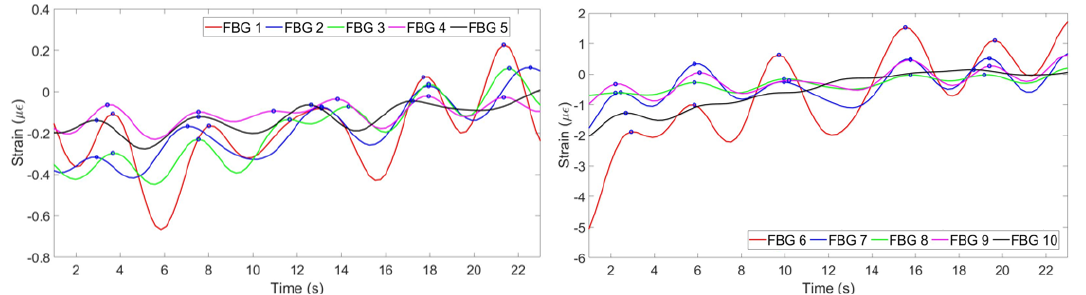
Figure 22. Breathing pattern for the first volunteer in the running position detected by: FBGs on the chest ( left ) and abdomen regions ( right ).